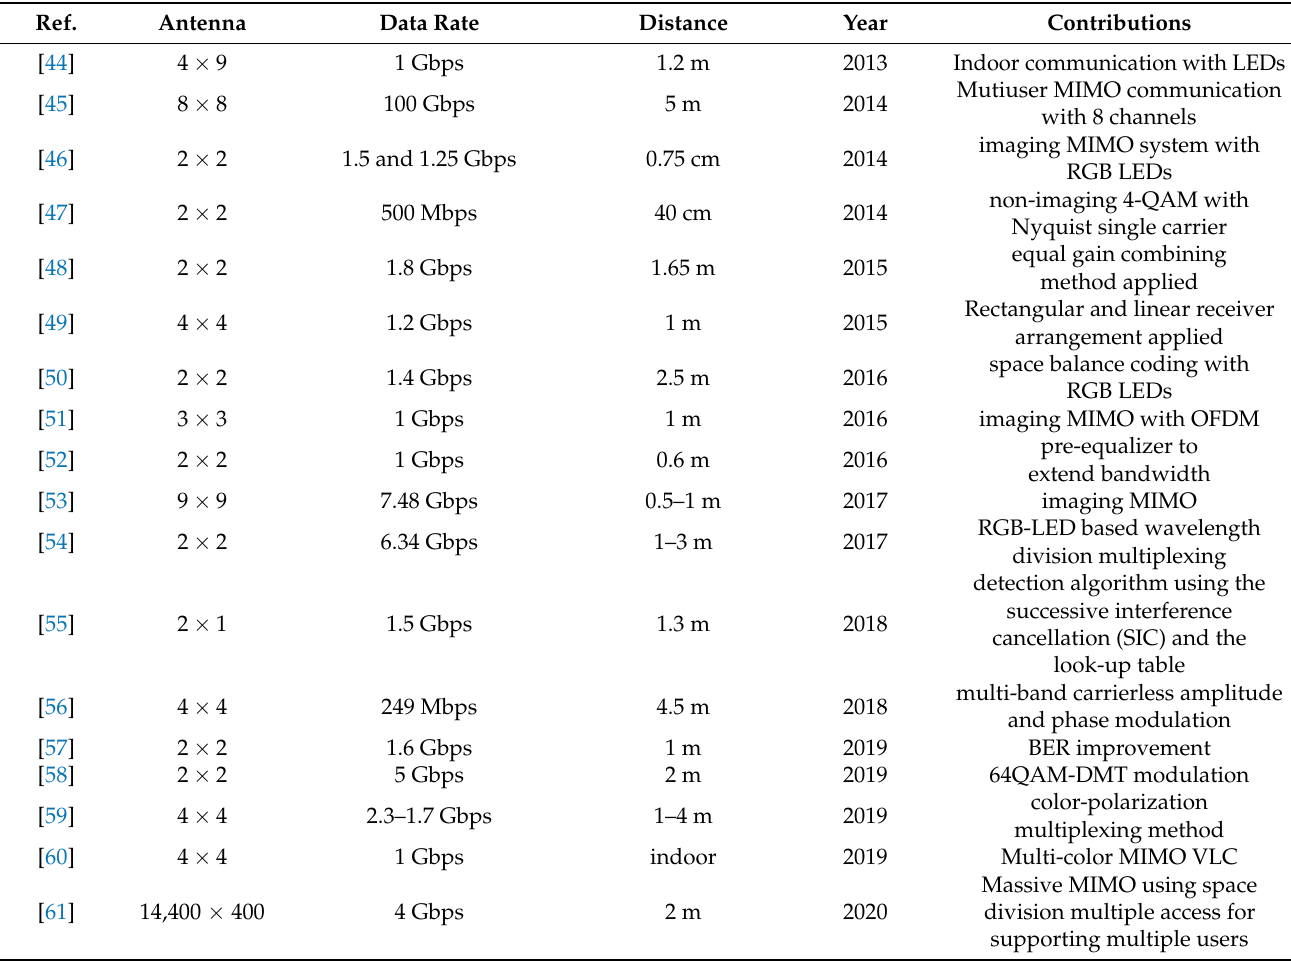
Table 2. A list of studies with significant data rates for MIMO VLC.